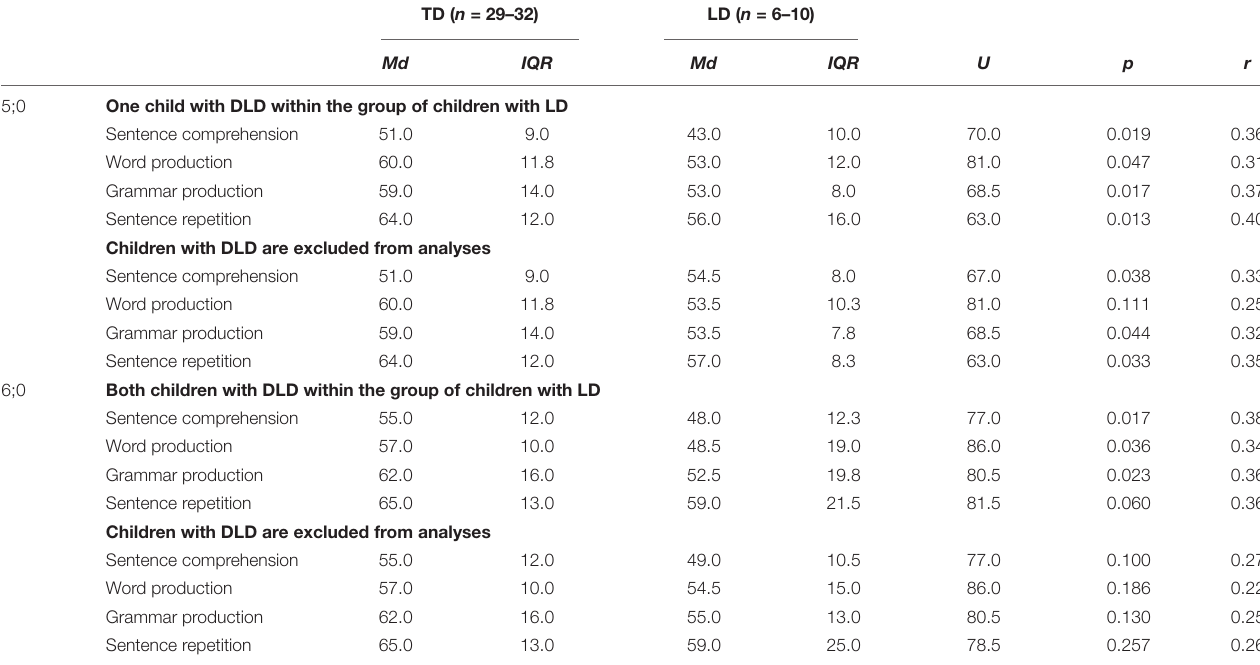
TABLE 5 | Comparison of the language skills of children with and without a history of